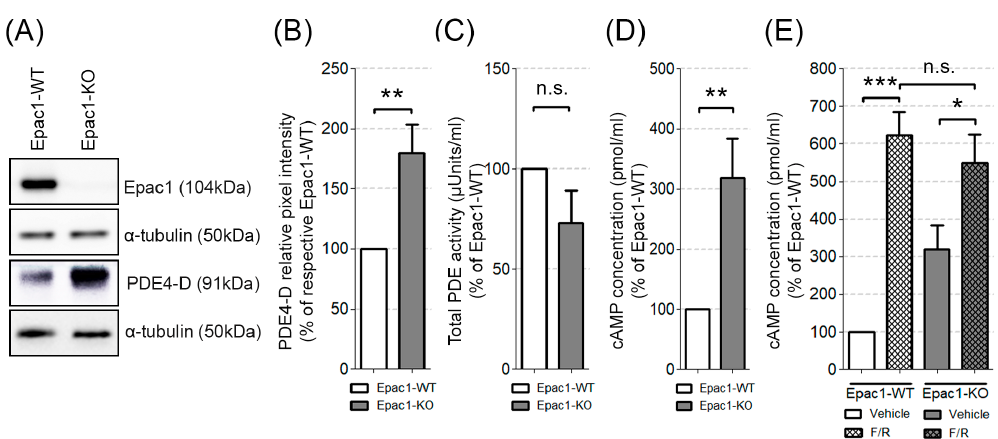
Figure 5. Expression of PDE4-D and intracellular levels of cAMP. ( A ) Western blot analysis of PDE4-D; α -tubulin was used as the loading control, N ≥ 5. ( B ) Densitometric evaluation of the PDE4-D band intensity, N ≥ 5. ( C ) Total basal PDE activity of Epac1-KO and the corresponding WT control cells, N = 4, n ≥ 8. ( D ) The basal intracellular cAMP levels in the WT and Epac1-KO endothelial cells; N ≥ 10. ( E ) The cAMP levels of the WT and KO cells subjected to F / R, N ≥ 5; * p ≤ 0.05, ** p ≤ 0.01, *** p ≤ 0.001; “n.s.” denotes non-significant di ff erences between the analyzed